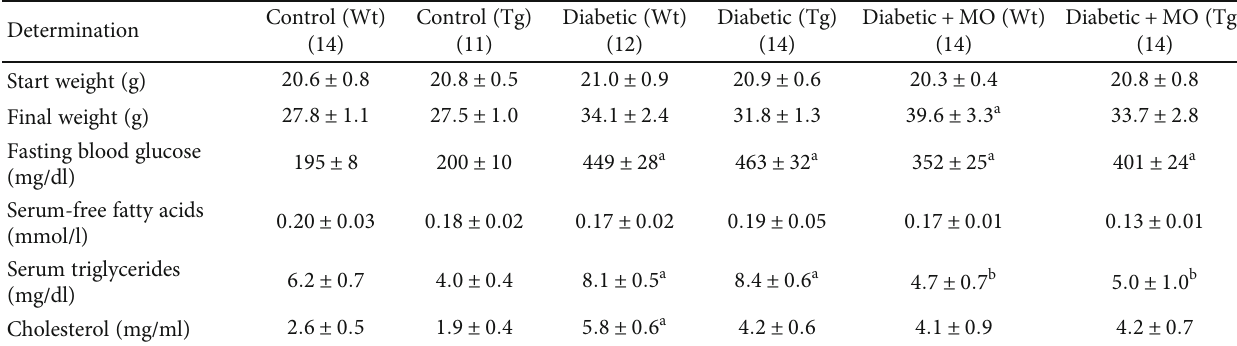
Table 1: E ff ect of menhaden oil treatment of diabetic wild-type (Wt) or 15-LOX-1 transgenic (Tg) mice on serum free fatty acid, triglyceride, and cholesterol levels.